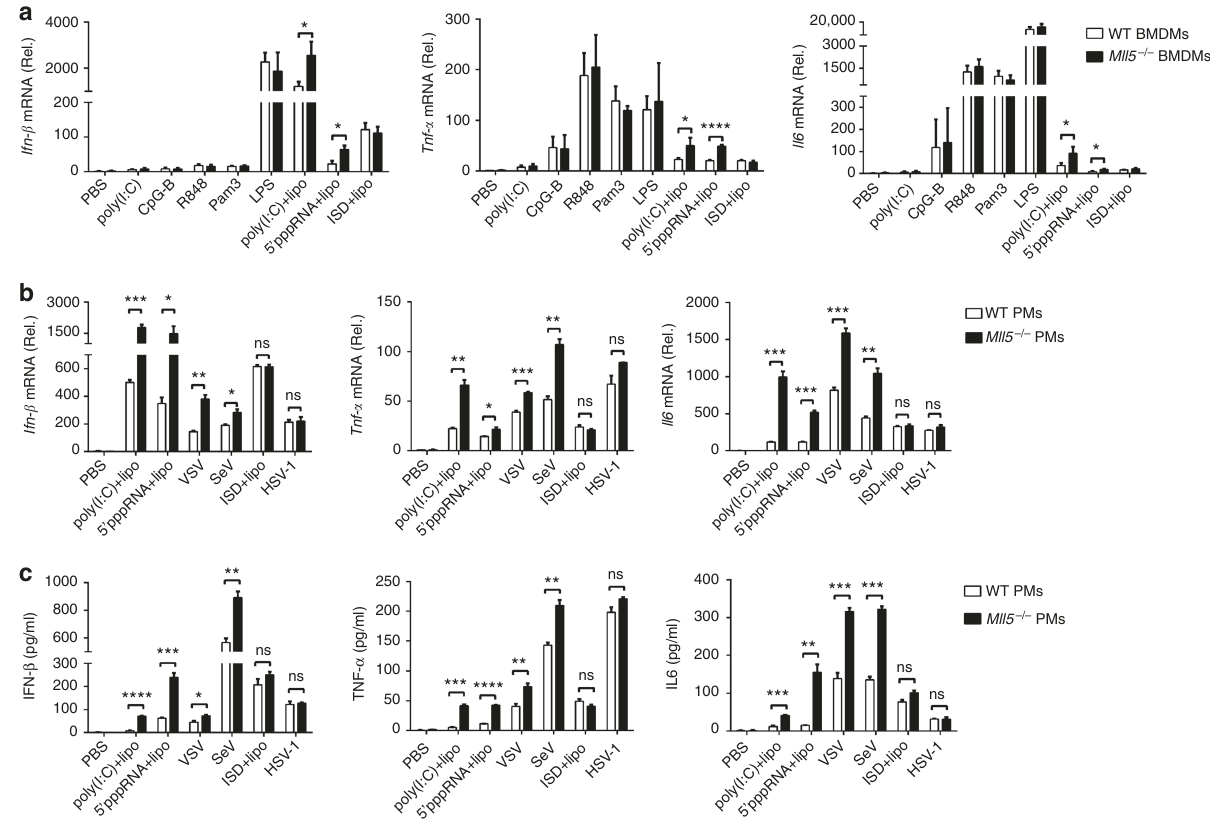
Fig. 1 MLL5 selectively suppresses RLR-mediated antiviral immune response. a Expression of Ifn- β , Tnf- α , and Il6 mRNA in BMDMs from wild-type (WT) or Mll5 − / − mice stimulated with poly(I:C) (100 μ g/ml), CpG-B (1 μ g/ml), R848 (1 μ g/ml), Pam3 (1 μ g/ml) and LPS (0.2 μ g/ml) for 4 h, or stimulated with intracellular poly(I:C) (1 μ g/ml), intracellular 5 ′ ppp-RNA (0.4 μ g/ml) and intracellular ISD (1 μ g/ml) for 6 h. Gapdh served as control. b Expression of Ifn- β , Tnf- α and Il6 mRNA in PMs from WT or Mll5 − / − mice stimulated with intracellular poly(I:C) (1 μ g/ml), intracellular 5 ′ ppp-RNA (0.4 μ g/ml) and intracellular ISD (1 μ g/ml) for 6 h, or infected with VSV-GFP (MOI:1), SeV (10 HA/ml) and HSV-1 (MOI:1) for 6 h. Gapdh served as control. c ELISA quanti fi cation of IFN- β , TNF- α and IL6 secretion in PMs treated as in b . Data were from three independent experiments and were analyzed by Student ’ s t -test (two-tailed) and were presented as mean ± SD (* p < 0.05, ** p < 0.01,*** p < 0.001, **** p < 0.0001, ns means no signi fi cant